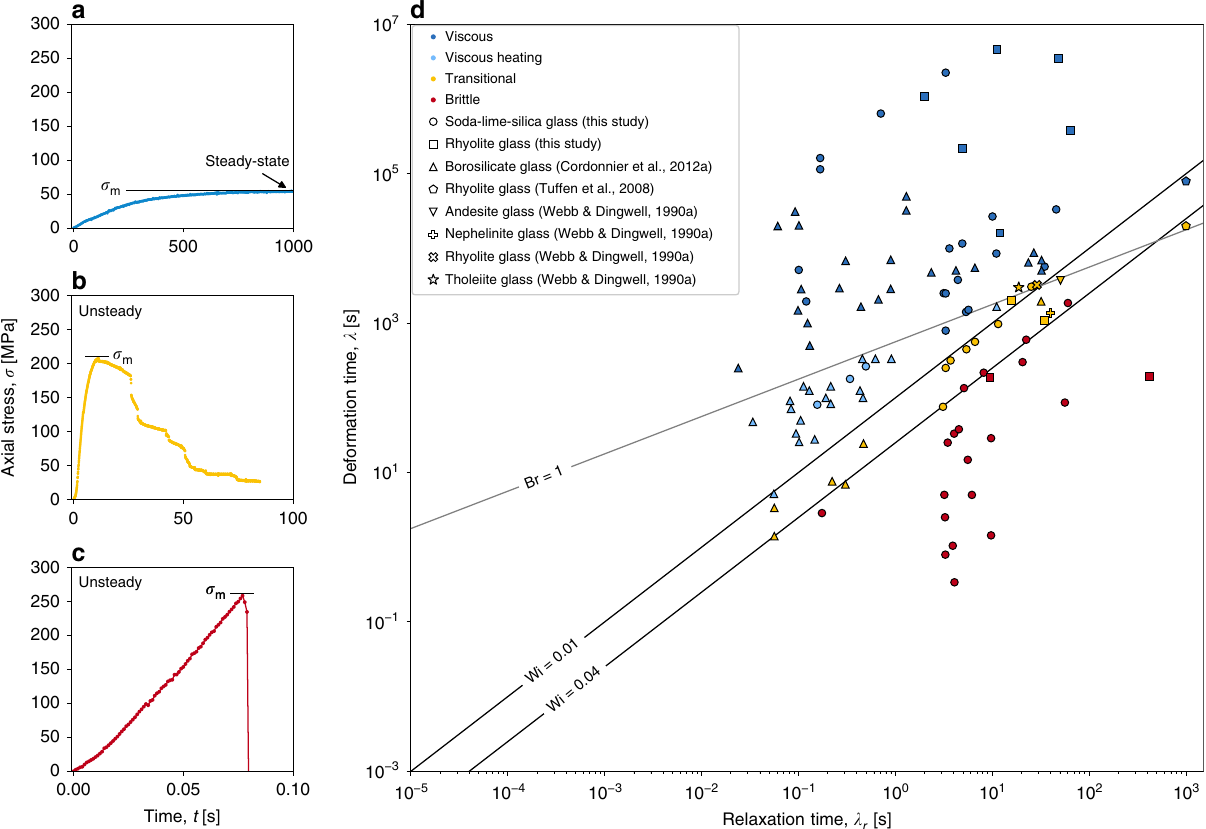
Fig. 2 A regime diagram for the brittle failure of viscoelastic magmatic liquids. a – c Constitute the map key (or legend) for navigating through frame d and indicate typical behaviours cast as the evolution of an axial loading stress σ at high, moderate and low timescales of deformation λ , producing a a viscous, b transitional viscous-brittle, and c purely brittle response to loading, respectively. d A regime diagram in which experiments at constant λ are plotted as a function of the relaxation time λ r and coloured according to the macroscopic response observed (see map key at left a – c ). Results of this study are compared with a reanalysis of previous experimental results for magmatically-relevant pure liquids 22, 26, 35 . All data are consistent with viscous behaviour at Wi < 0.01 and brittle behaviour at Wi ≳ 0 : 04. Where G ∞ was not known, we have taken 10 10 Pa for silicate liquids 28,